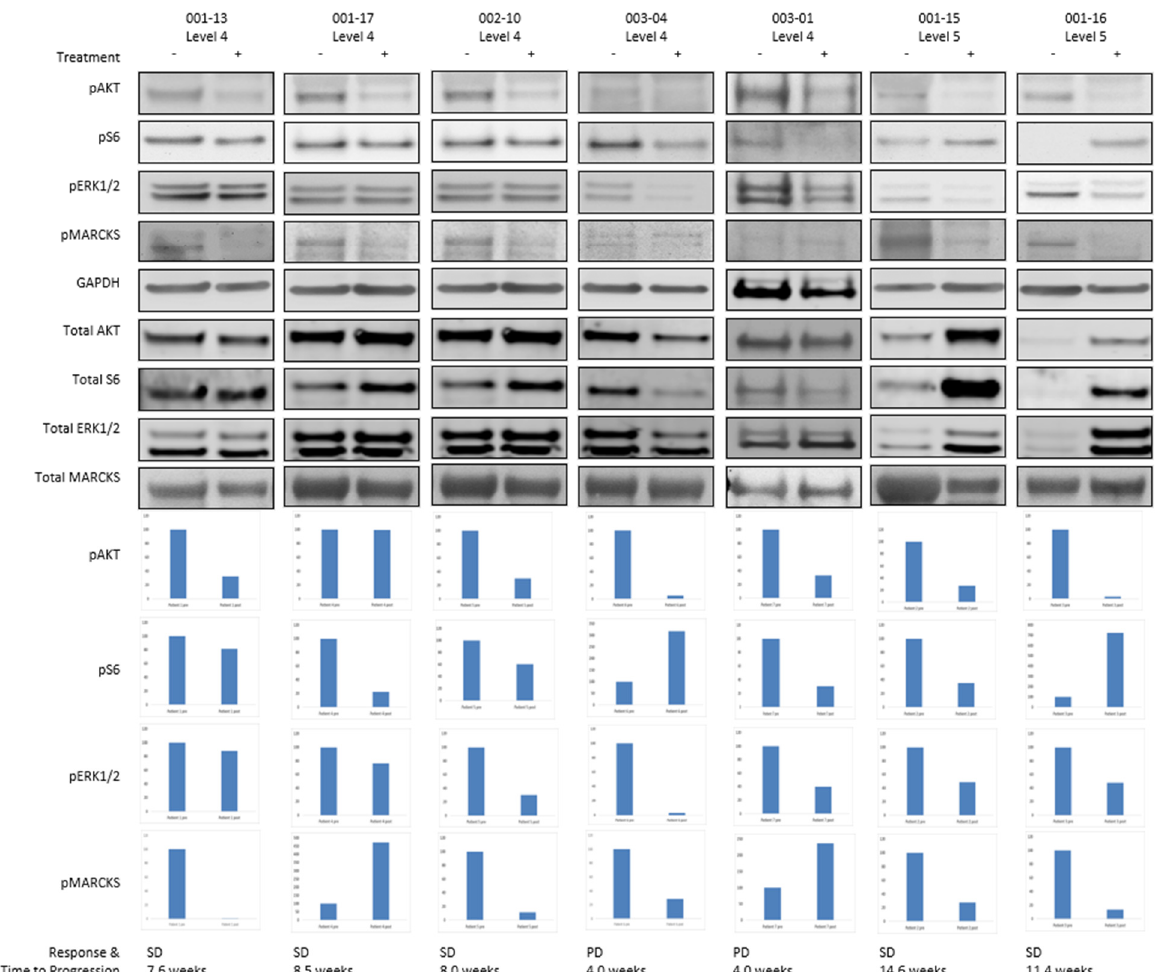
Figure 3. Western blot analysis of PKC and PI3K α -AKT-mTOR pathway inhibition. Paired tumor biopsies were assessed by Western blot for pAKT, pS6, pERK1/2, pMARCKS, and the respective total proteins. GAPDH was used as a loading control. Clinical outcomes for these respective patients are listed. Protein quantitation of the pre-treatment (left) and post-treatment (right) Western blot analysis performed with Image J. The pre-treatment sample expression level represents a baseline of 100%, with the post-treatment sample expression levels relative to this baseline. Bar plots represent pAKT/total AKT, pS6/total S6, pERK1/2/ total ERK1/2, and pMARCKS/MARCKS, respectively.